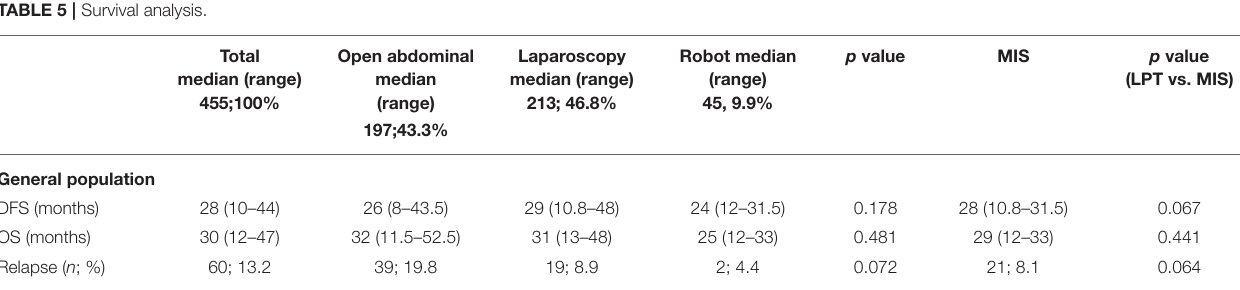
TABLE 5 | Survival